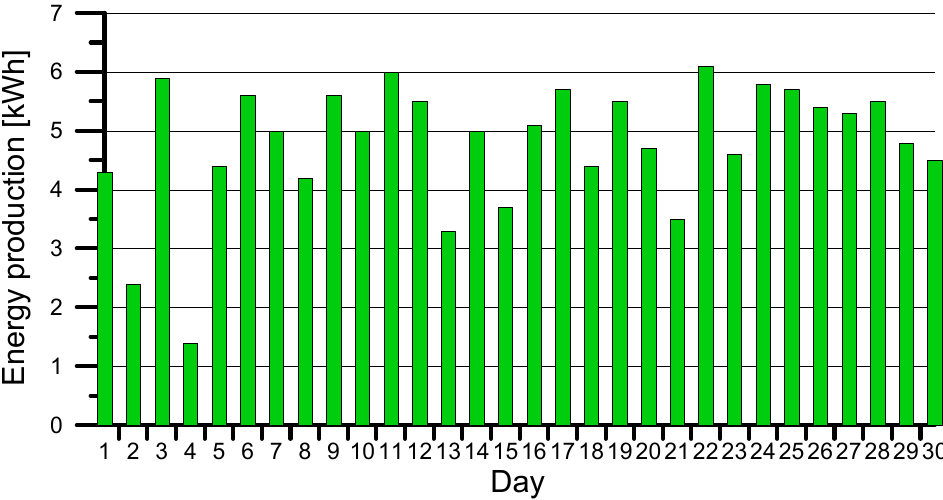
Figure 5. Daily electricity production by the WSEI mini carport in June 2022. The Metalog family of distributions, parametrized with quantiles, allows us to de- termine the percentiles in the production of electricity by a photovoltaic carport and to determine what its value will be with the accuracy of the probability distribution (Table 1).